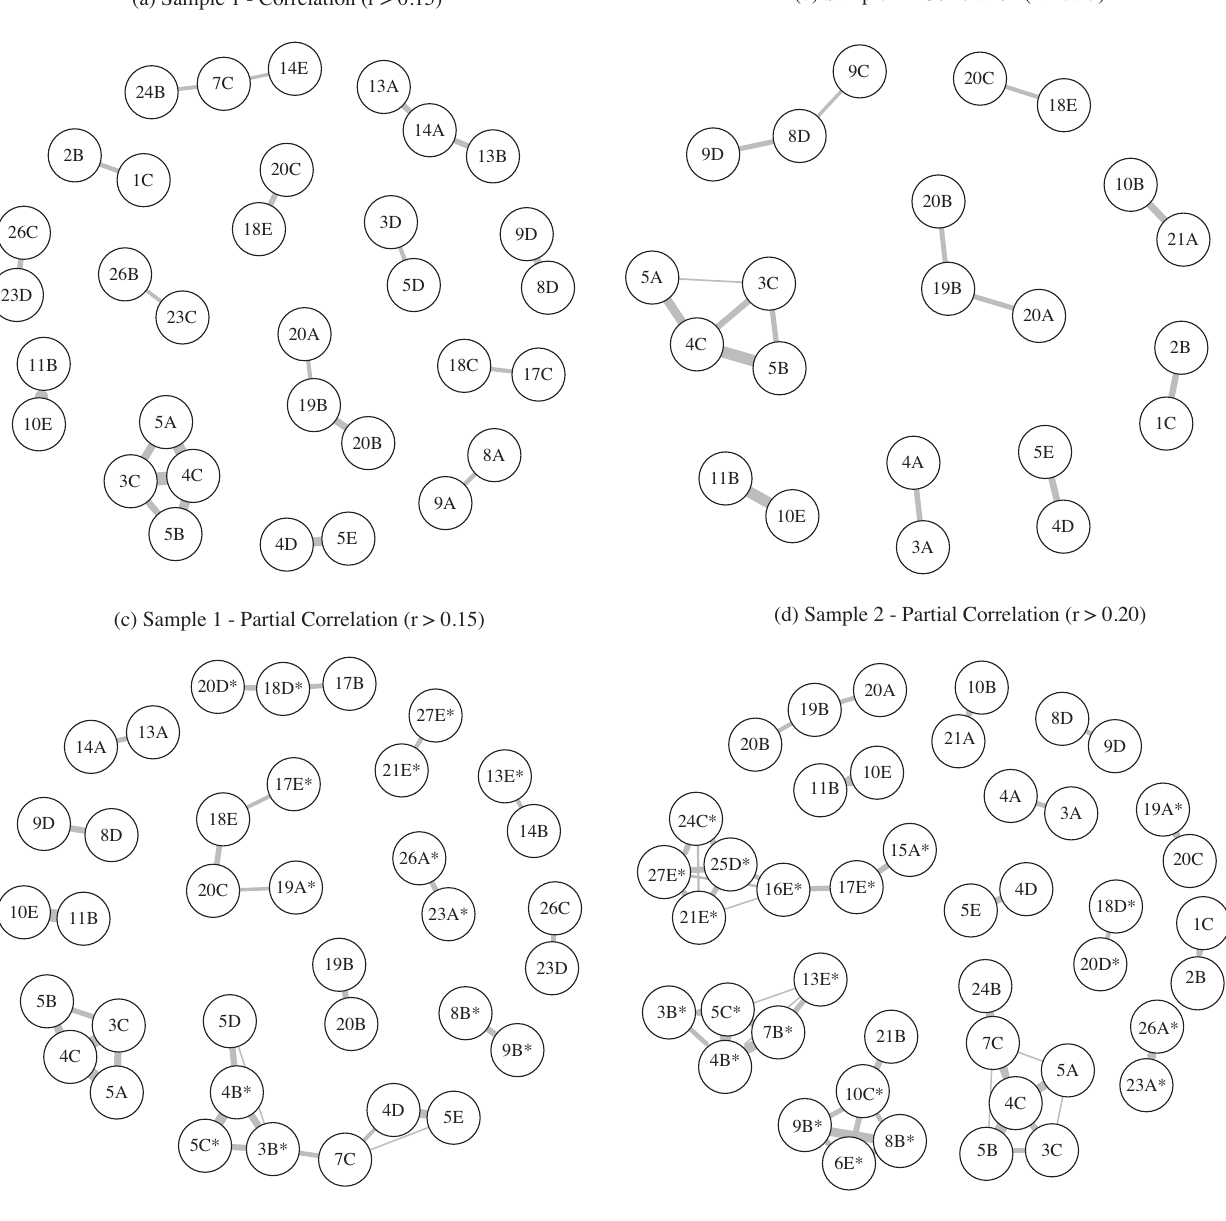
FIG. 1. Communities detected in the CSEM. (a) The correlation network for sample 1. (b) The correlation network for sample 2. (c) The partial correlation network for sample 1. (d) The partial correlation network for sample 2. The strength of the correlation or partial correlation is represented by the line thickness. Weaker correlation lines have been enhanced to be a minimum width for